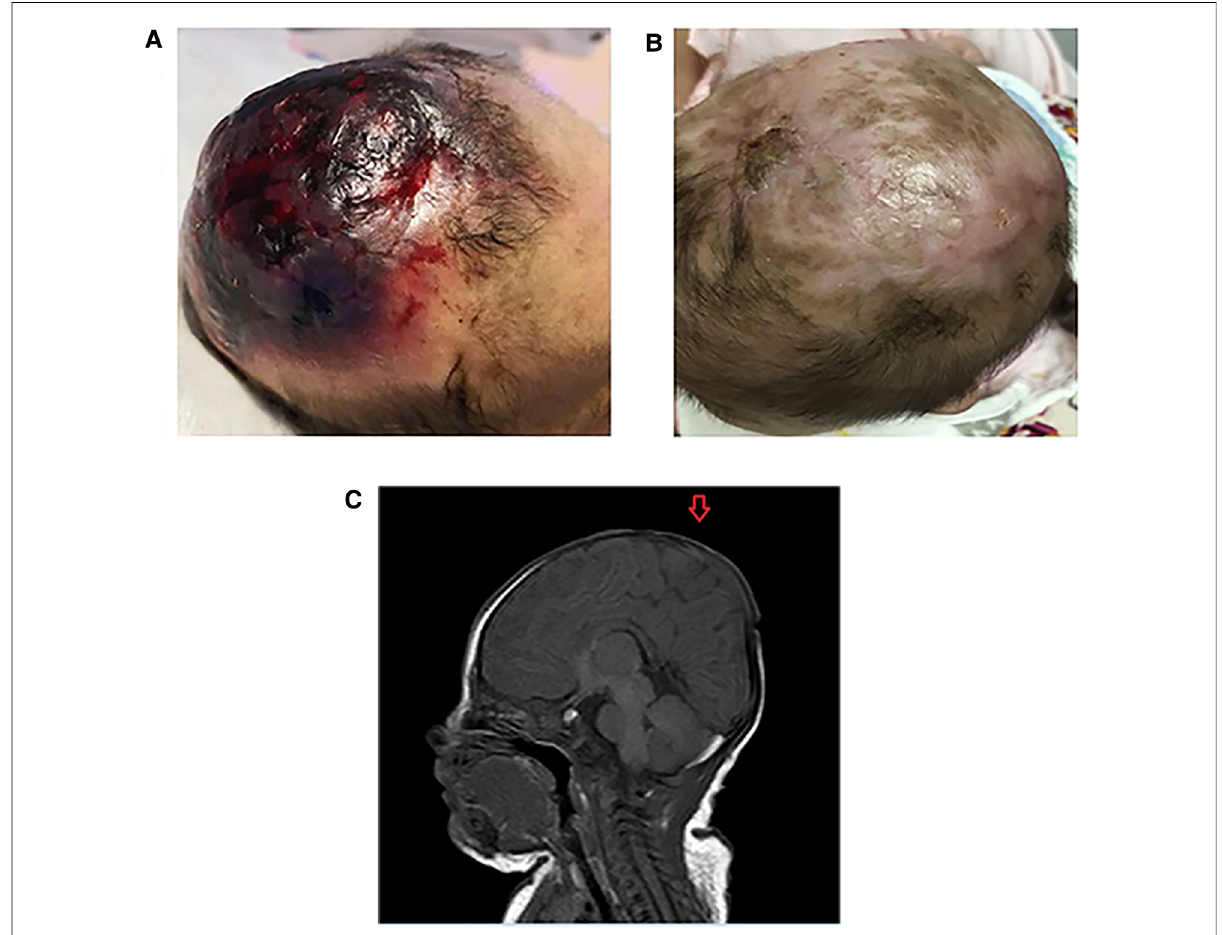
FIGURE 1 ( A ) The scalp defect of the patient with AOC at birth. ( B ) The scalp of the patient with AOC at 5 months old. ( C ) Cranial magnetic resonance imaging scan of the patient with aplasia cutis congenital (AOC). The scan shows a complete loss of continuity of the dermal, subcutaneous, and skull tissues